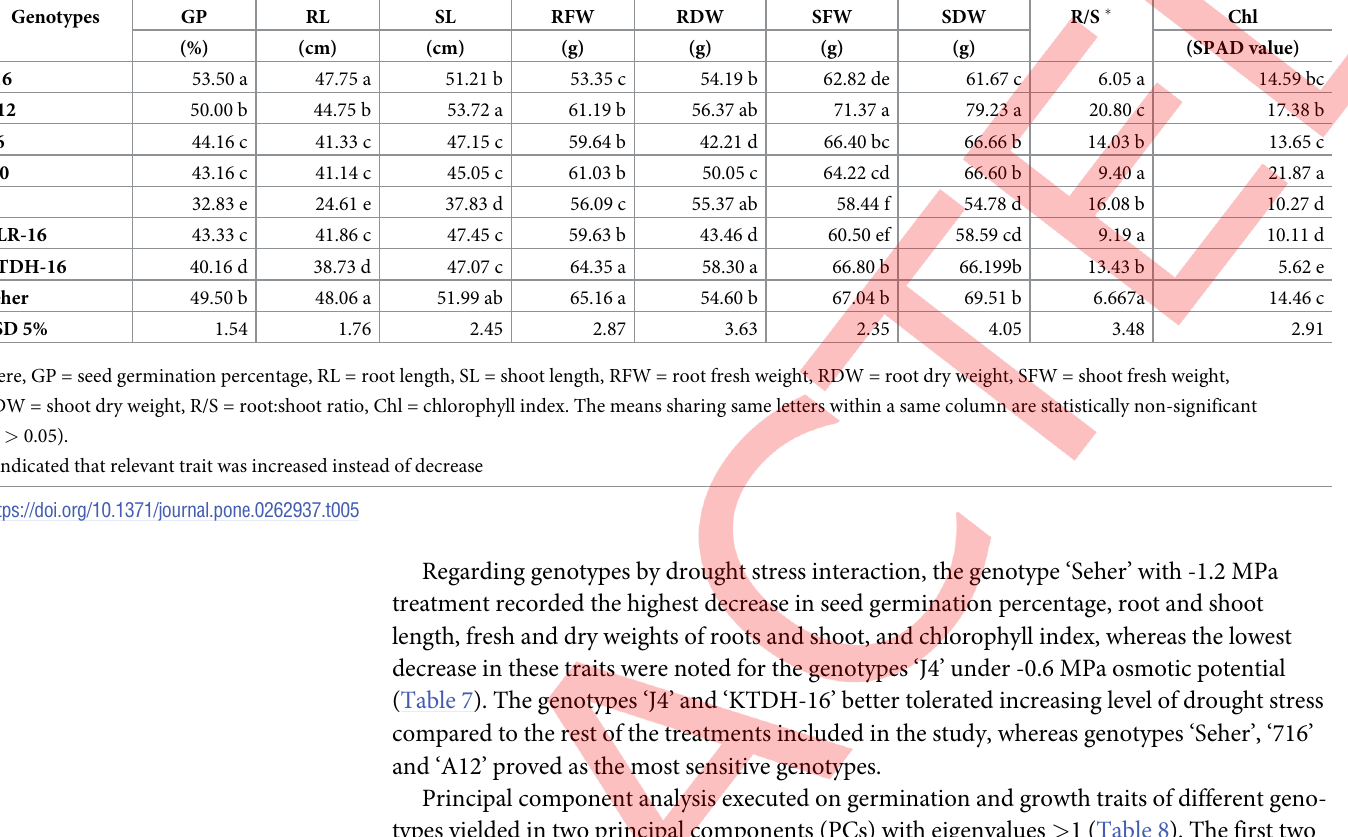
Table 5. The impact of different genotypes on percentage decrease in their seed germination and growth traits under different osmotic potentials. Genotypes GP